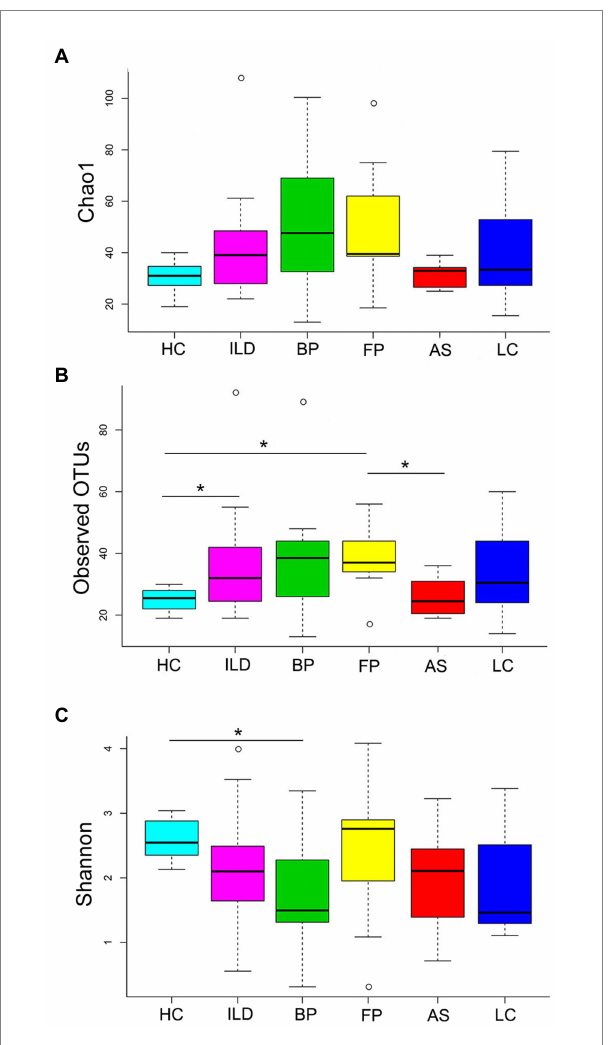
FIGURE 2 The α -diversity analysis of the identified OTUs. (A) Chao1; (B) observed OTUs; (C) Shannon index. Significant differences between each pair of groups were calculated with Student’s t -test, and the p values were corrected for multiple testing. * indicates P adj <